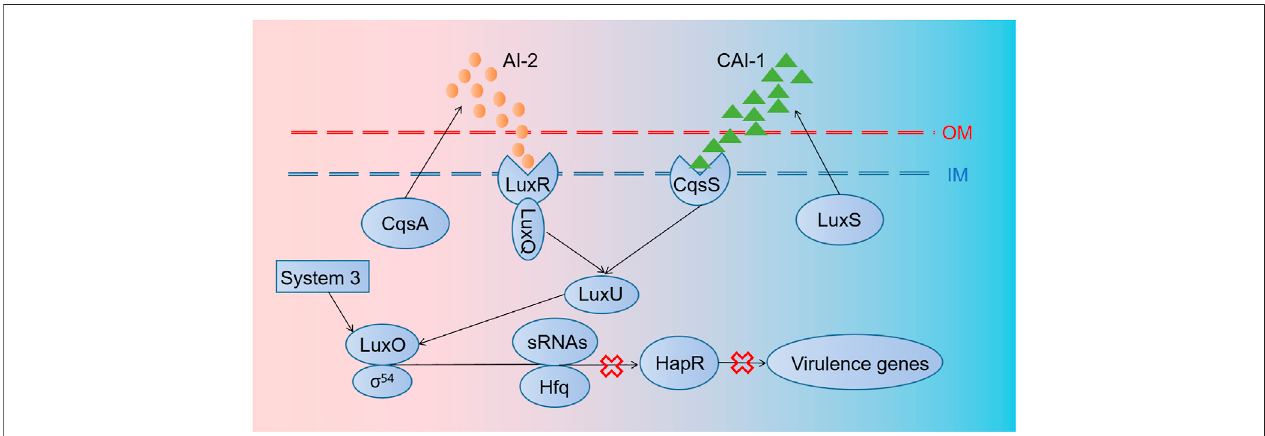
FIGURE2| Regulation mechanisms ofquorum sensingin V.cholerae. The parallel QSsystem of V.cholerae possesses AI-2/LuxPQand CAI-1/CqsS systems, as wellasanunidenti fi edthirdcircuitthatactsthroughLuxO. cqsA and luxS genesencodeproteinsproducingAI-2andCAI-1.Thereafter,AI-2andCAI-1aredetectedand captured by LuxRQ complex and CqsS, respectively, leading to the activation of LuxU and LuxO later. Then, with the aid of σ 54 , sRNAs and their chaperones Hfq are transformed into sRNAs – Hfq complex, which inhibits the transcription of HapR mRNAs, thus blocking the forming of HapR, a transcription factor relevant to the expression of some virulence